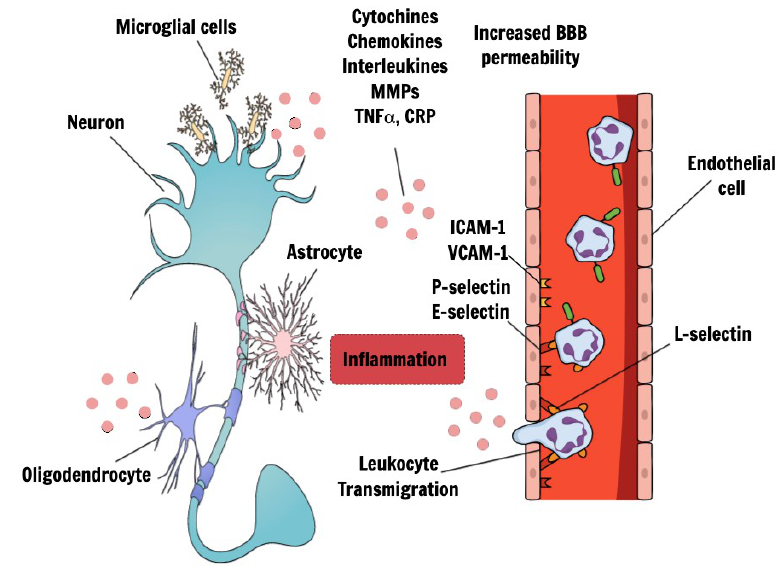
Figure 1. Endothelial dysfunction and cerebral inflammatory response in VCID. Endothelial dysfunction, observed in VCID, could lead to an increase in BBB permeability, a subsequent exposure of neural cells to harmful substances and a rise of inflammatory environment. The result is an activation of glial cells in the CNS, which finally lead to neuron damage. During inflammatory response, leukocytes are recruited from the circulation into the extravascular space. The activation of endothelial cells lead to the expression of adhesion molecules on their surfaces, allowing the binding to reciprocal molecules on the surfaces of circulating leukocytes. Indeed, activated endothelial cells up-regulate the expression of adhesion molecules such as intercellular adhesion molecule-1 (ICAM-1), vascular cell adhesion molecule-1 (VCAM-1) and selectins (P-selectin, E-selectin). L-selectin is mainly expressed on leukocytes. The increased BBB permeability lead to infiltration of inflammatory factors like interleukins, chemokines, cytochines, MMPs, TNFα, TLR4, CRP. Upon entry into the brain, these inflammatory factors can exacerbate white matter damage (demyelination, axonal loss, oligodendrocyte degeneration), cause neurodegeneration and cell death as well as enhance neuroglial inflammation. (VCID: vascular cognitive impairment and dementia; BBB: blood–brain barrier; CNS: central nervous system; MMPs: TNFα: Tumor necrosis factor; CRP: C-reactive protein).